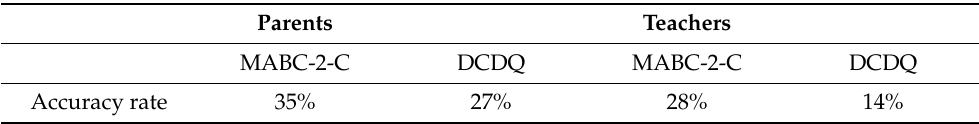
Table 8. The accuracy rate of parent and teacher reports from MABC-2-C and DCDQ to identify children with suspected DCD ( n = 172).